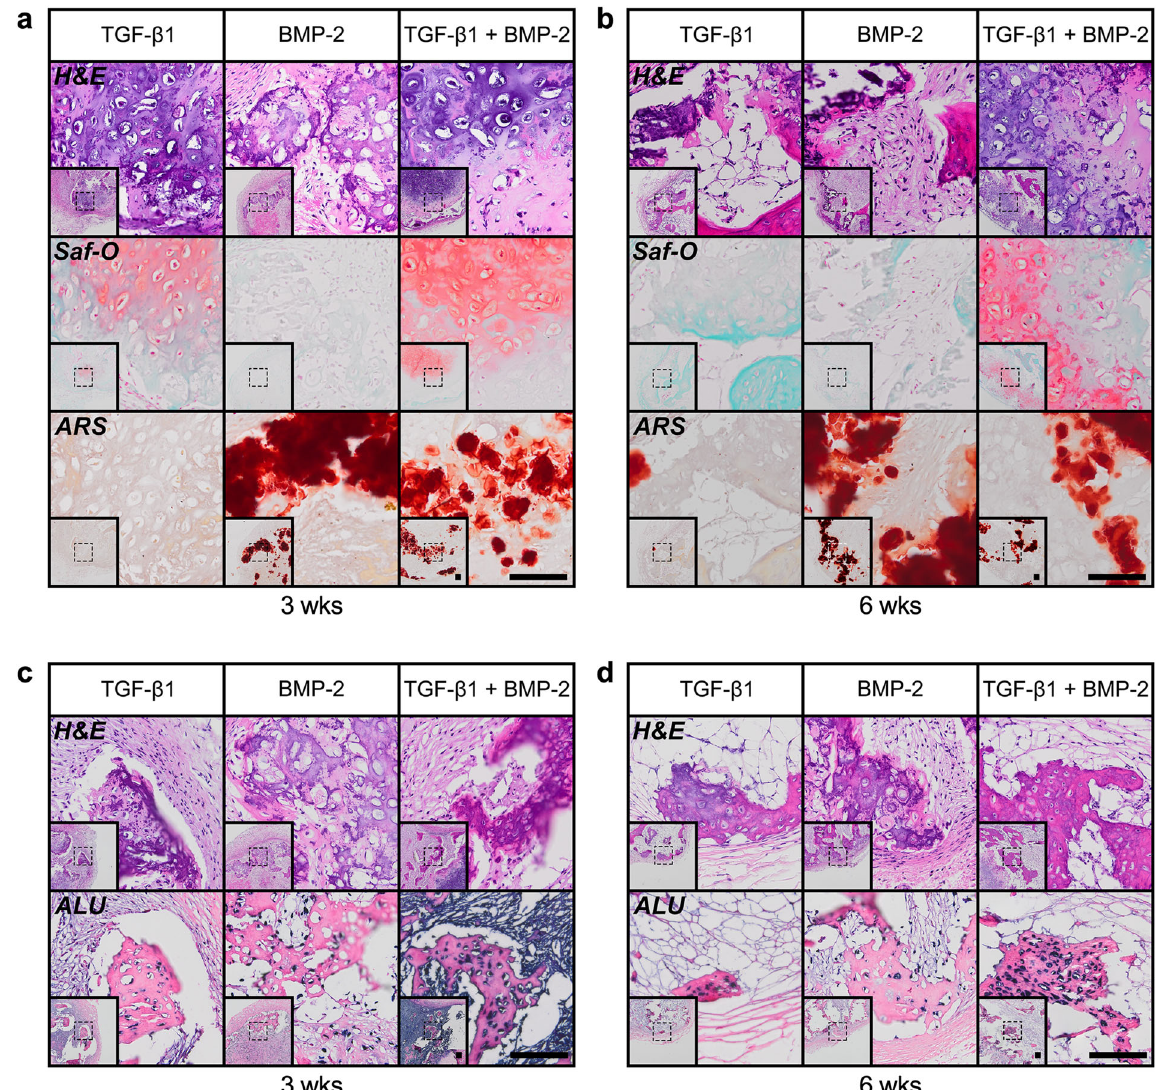
Fig. 5 Ex vivo histological evaluation of subcutaneous bone tissue induced by engineered hMSC condensate tubes. a , b Representative histological Hematoxylin & Eosin (H&E), Safranin-O/Fast-green (Saf-O), and Alizarin Red S (ARS) staining of sagittal sections of hMSC tube explants containing TGF- β 1-loaded, BMP-2-loaded, or TGF- β 1 + BMP-2-loaded microparticles at weeks 3 and 6. c , d Representative H&E staining and in situ hybridization for human Alu repeats of transaxial hMSC tube explant sections at weeks 3 and 6. Scale bars, 100 μ m (dotted squares in insets show region of interest in high magni fi cation